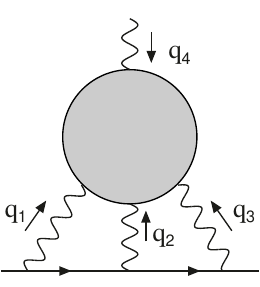
Figure 1 . The HLbL contribution to the ( g − 2) µ